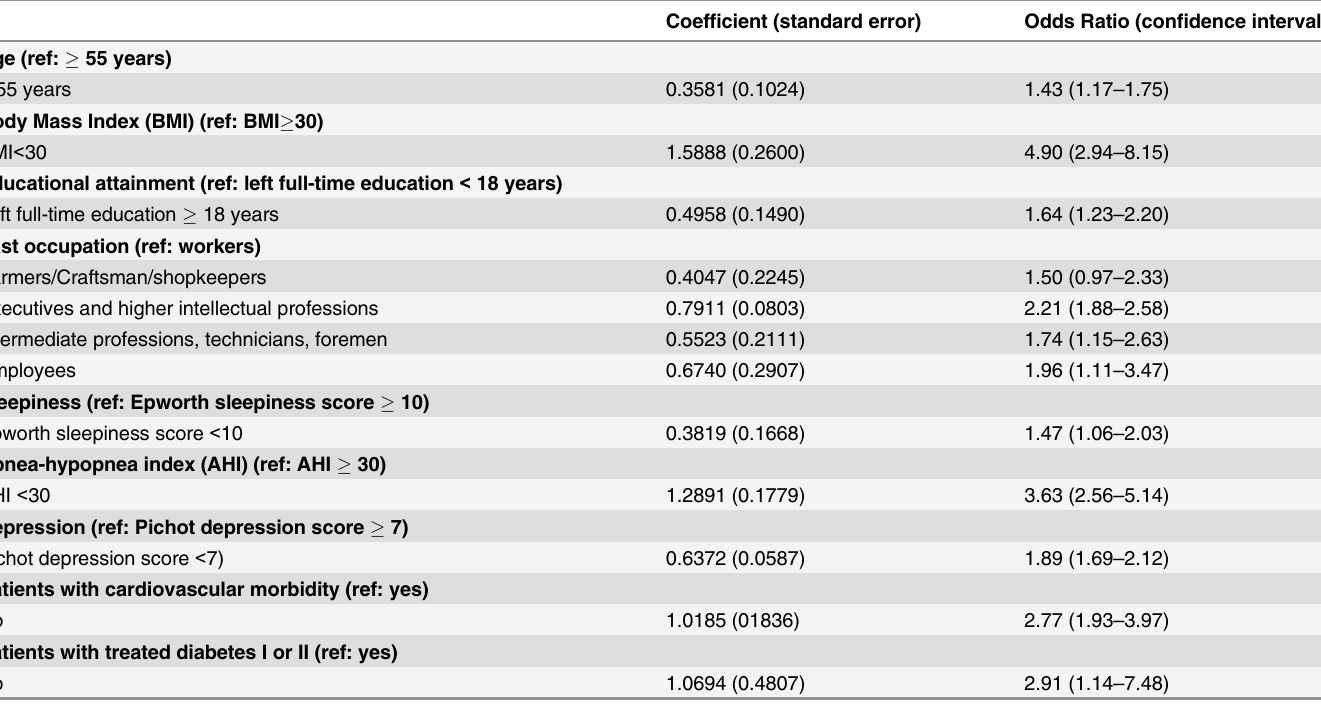
Table 2. Stepwise regression analysis of variables influencing MAD therapy (n = 2822).